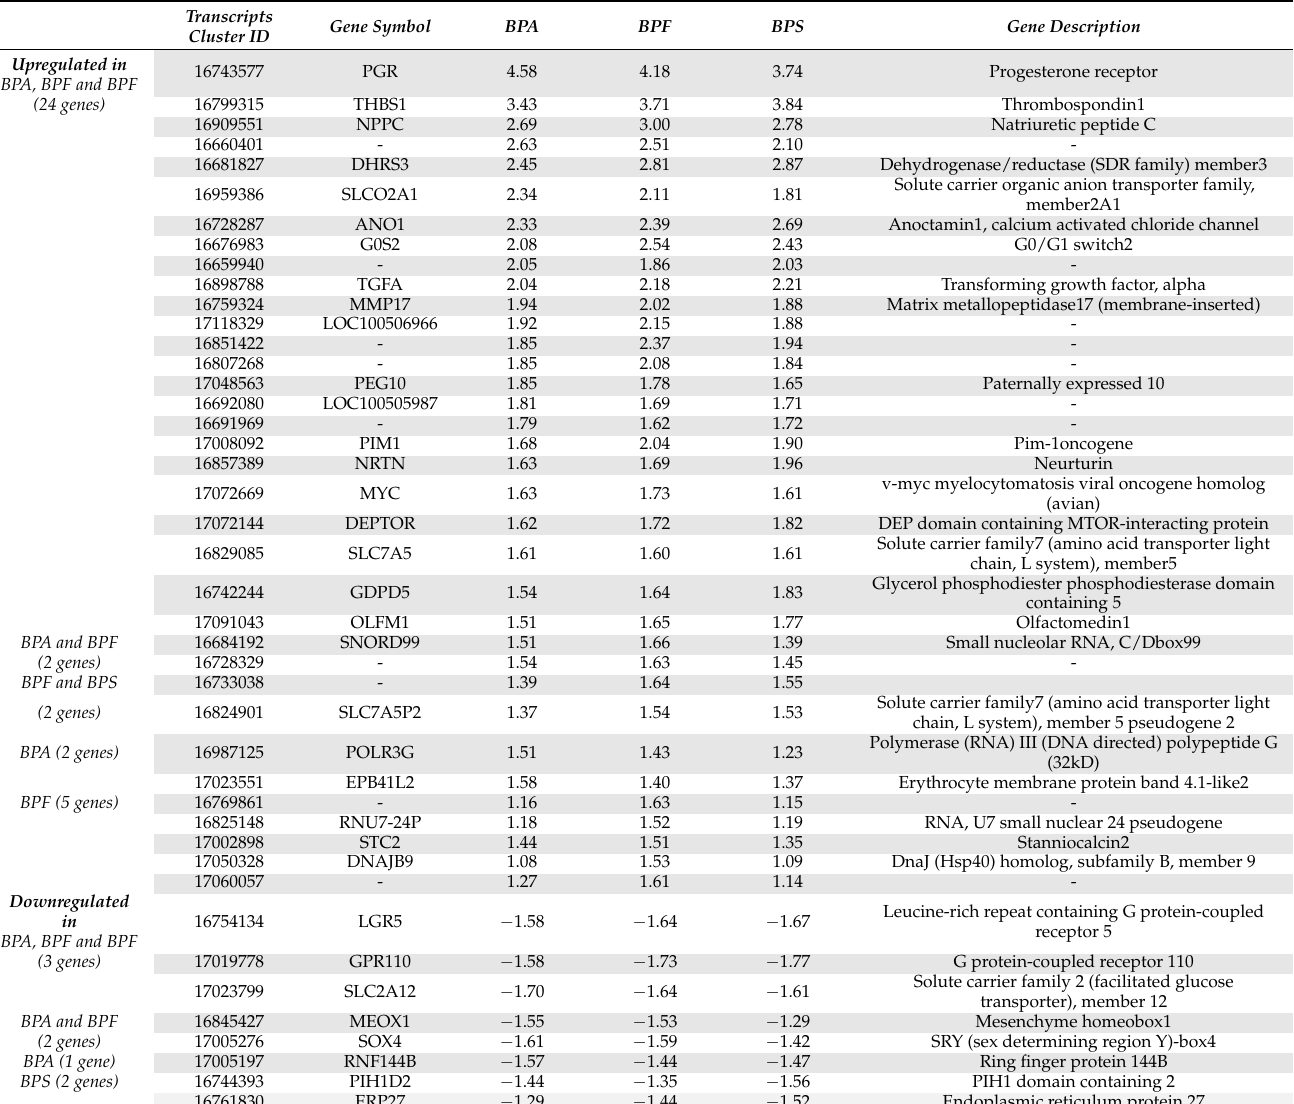
Table 1. Genes regulated by 10 µ M BPA, BPS and BPF in Ishikawa cell (fold change > 1.5, p <